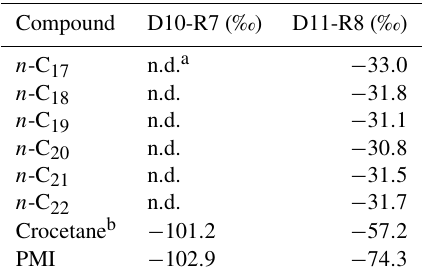
Table 5. Stable carbon isotopic composition ( δ 13 C) of selected lipid biomarkers (in Fig.